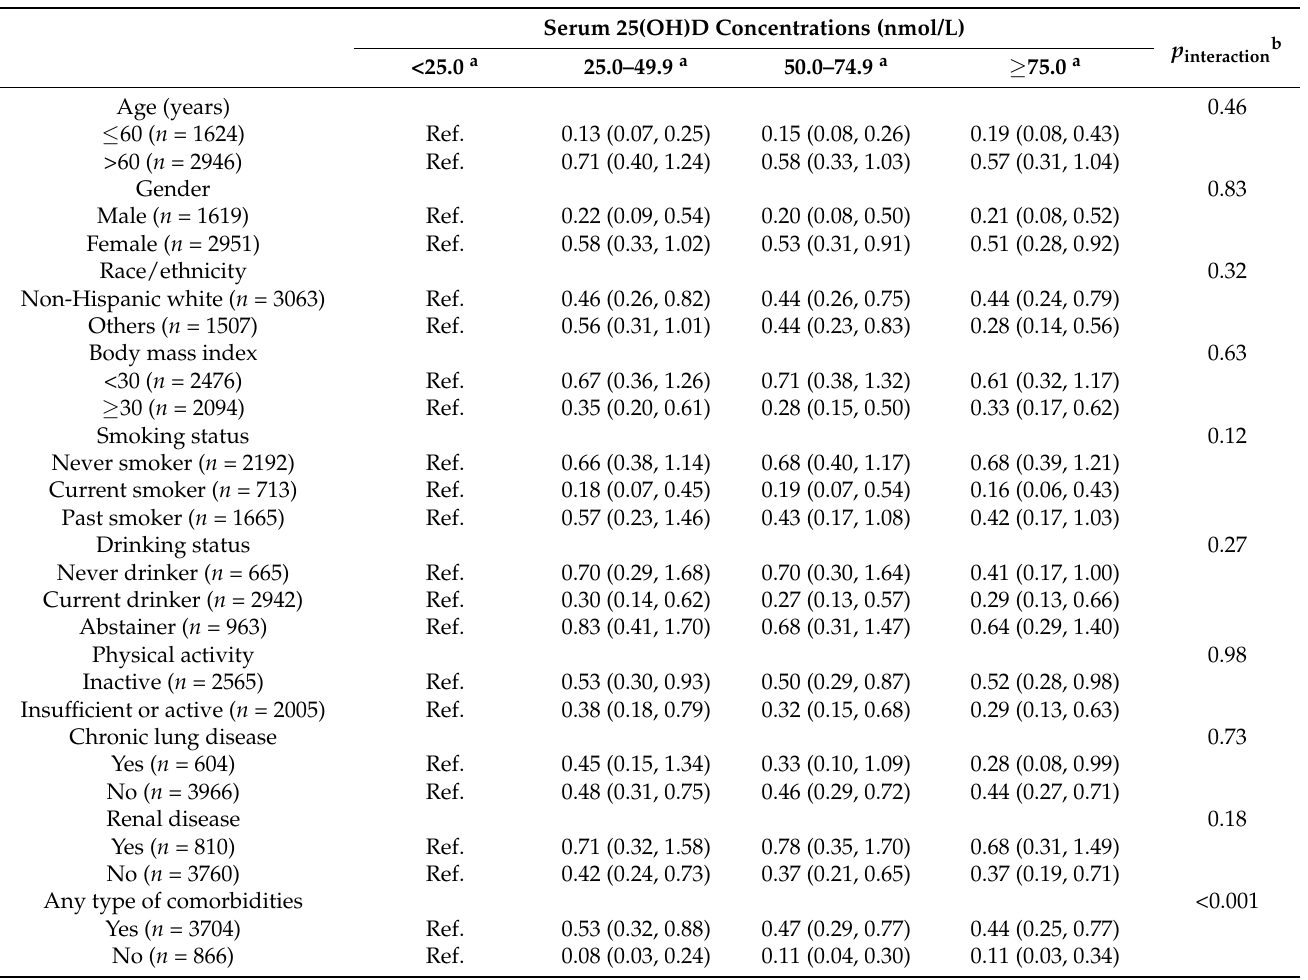
Table 3. Stratified analyses of the associations (HRs, 95% CIs) between serum 25(OH)D concentrations and all-cause mortality among OA patients in NHANES III and NHANES